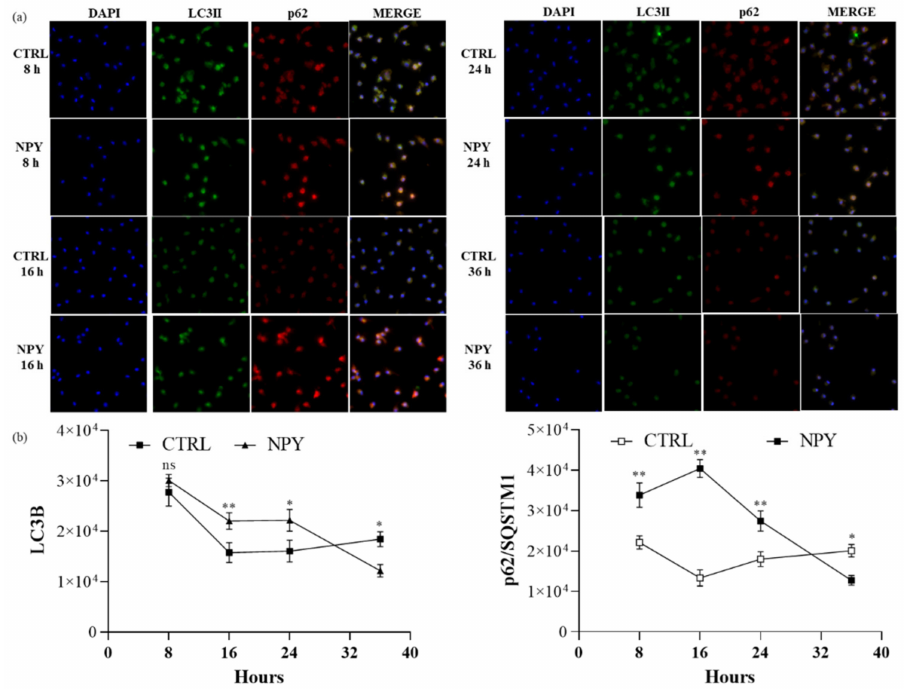
Figure 7. Immunofluorescent analysis of LC3B and p62/SQSTM1 expression in M0 macrophages at different time points after 10 − 8 M NPY exposure. ( a ) Representative immunofluorescent co-staining of LC3B and p62/SQSTM1. ( b ) Quantification of the intensity of the fluorescence signal for LC3B and p62 positive cells. DAPI was used to counterstain the nuclei. The upright microscope Nikon Eclipse Ni-U with 60 × magnification was used to capture micrographs. Immunofluorescence analysis was performed using the ImageJ software. Data are presented as the mean ± SD for each group ( N = 3). Significance was determined by one-way ANOVA followed by Tukey’s post hoc analysis; *: p < 0.05, **: p <